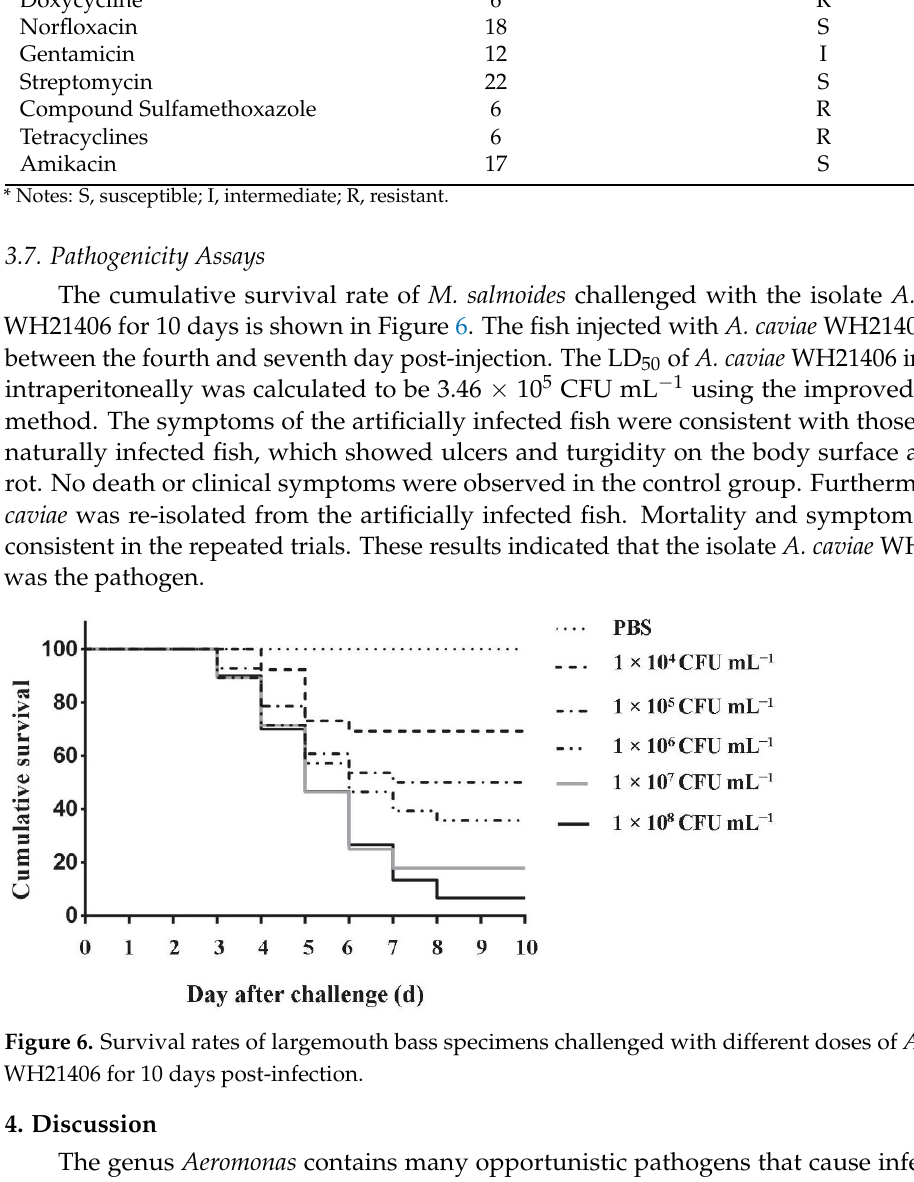
Table 3. Antibiotic susceptibility test results.